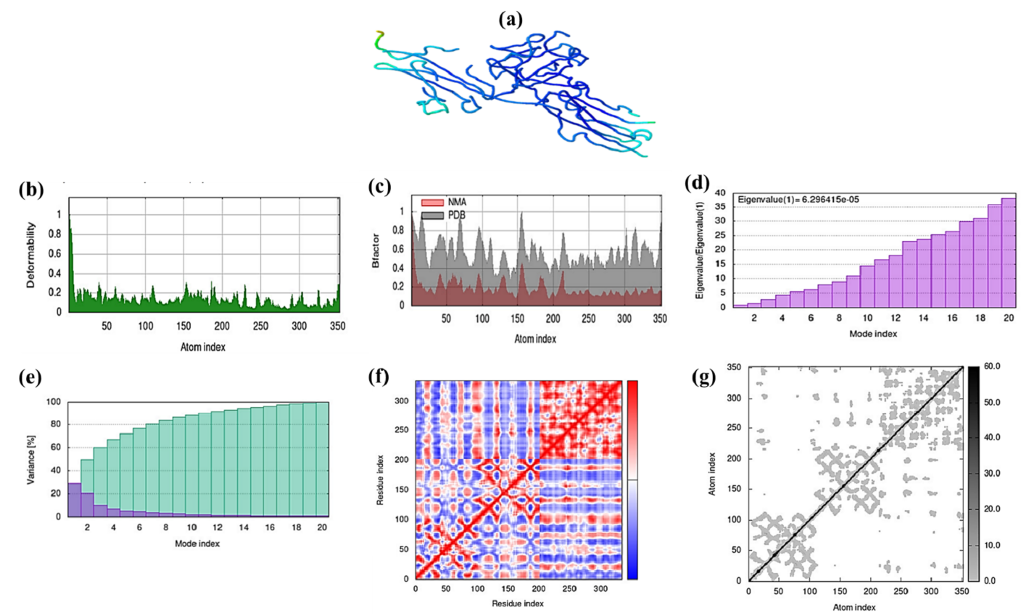
Figure 14. Molecular Dynamics Simulations of the Chlorogenic acid docked with gene Muthy ( a ) shows the docked compound ( b ) shows the deformability, which indicates a low level of deformation at all the residues ( c ) shows the B-factor, ( d ) Eigon values are shown, and ( e ) indicates the variance explained in both purple and green ( f ) and ( g ) show the covariance and elastic network of the complex.